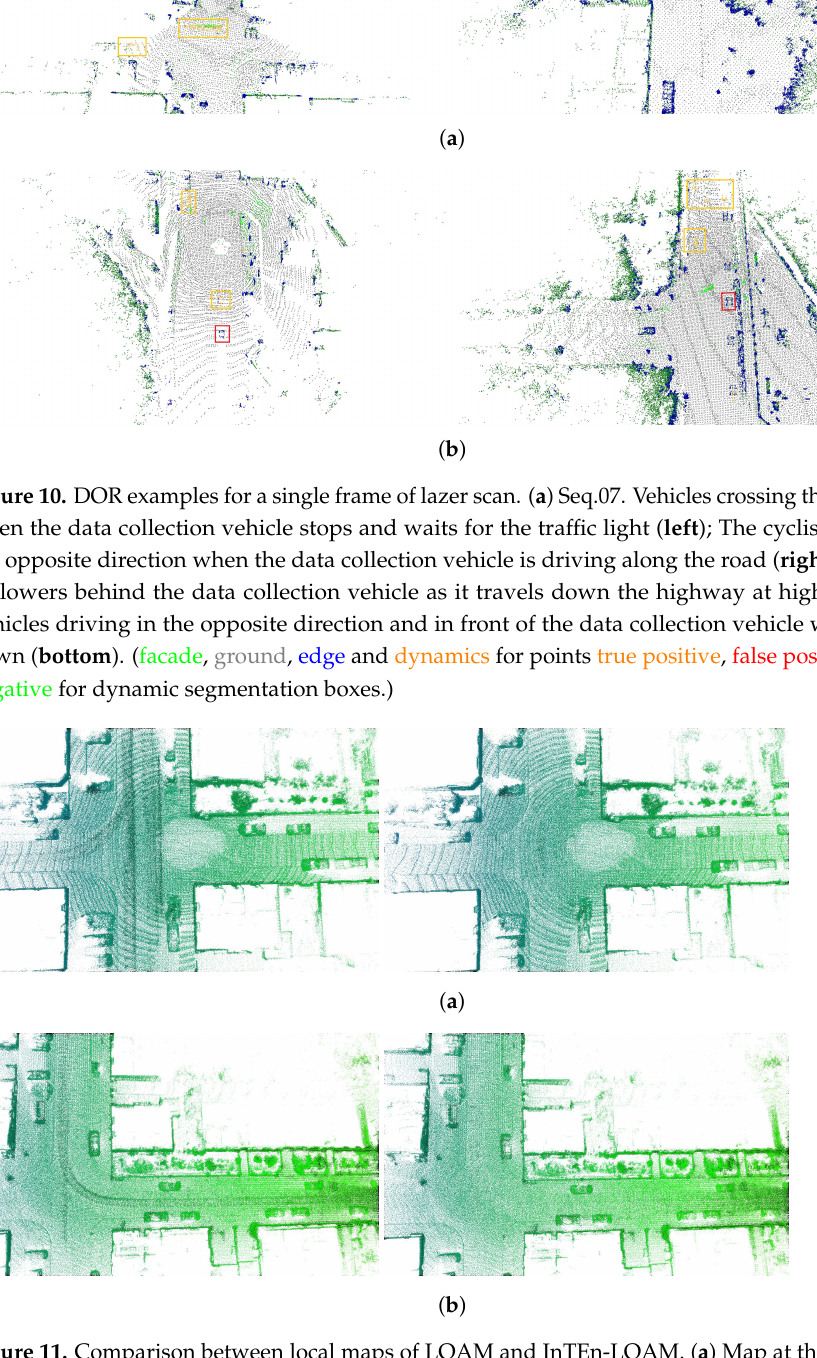
Figure 11. Comparison between local maps of LOAM and InTEn-LOAM. ( a ) Map at the intersection; ( b ) Map at the busy road. In each subfigure, the top represents the map of LOAM without DOR, while the bottom represents the map of InTEn-LOAM with